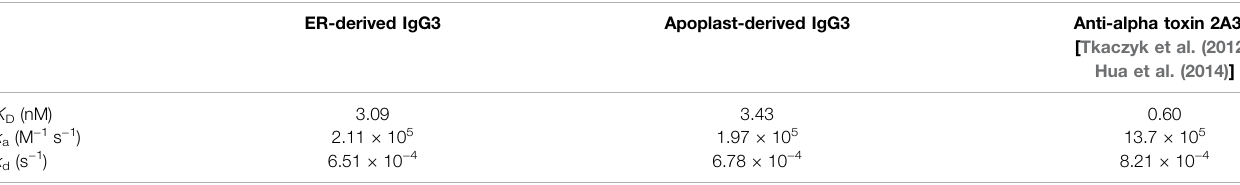
TABLE 2 | Comparison of empirical kinetic parameters determined for our plant-derived IgG3 antibodies directed against S. aureus alpha toxin with values presented in the literature. Kinetic parameters were calculated using the Biacore T200 evaluation software. K D (cid:2) equilibrium dissociation constant, k a (cid:2) association rate constant, k d (cid:2) dissociation rate